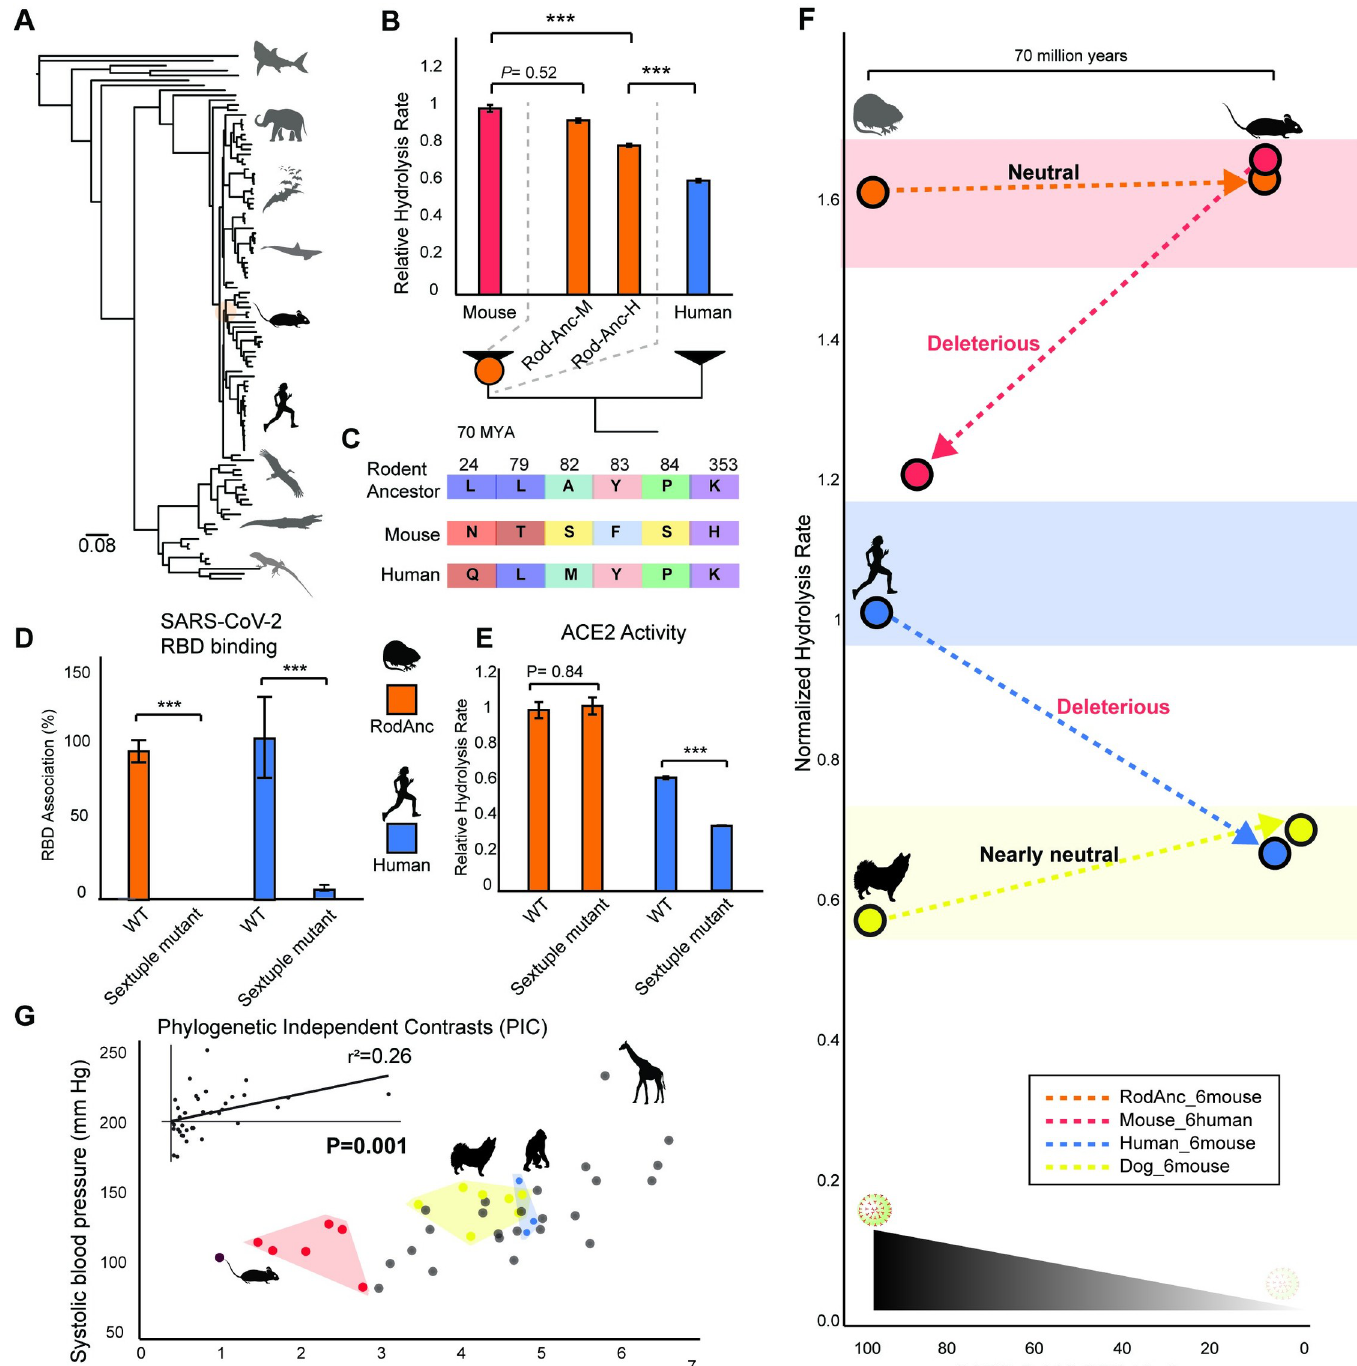
Fig 4. Alternative sequence–function optima in rodent ancestor ACE2 serendipitously confers resistance to SARS-CoV-2 in extant mice. (A) Phylogeny of jawed vertebrates used in the ancestral reconstruction of ACE2 from the last common ancestor of rodents (RodAnc). (B) Evolution of high ACE2 activity in the rodent ancestor. The carboxyl terminus of mouse (M) or human (H) was used to determine hydrolysis rates of a fluorometric peptide. N = 4 to 5 biological replicates. Standard error is shown. (C) RodAnc ACE2 displays none of the rare sequence variants unique to the RBD binding domain of mice. (D) Flow cytometry analysis of SARS-CoV-2 S RBD binding to RodAnc-M and human ACE2. Sextuple mutants of each contain the 6 mouse variants. N = 3 biological replicates. Standard deviation is shown. (E) Hydrolysis rates of WT and mutant ACE2. N = 5 biological replicates. Standard error is shown. (F) Residues conferring mice with resistance to SARS-CoV-2 are unlikely to evolve in humans due to antagonistic pleiotropy with human ACE2 hydrolysis rates. This antagonistic pleiotropy is absent from dogs and the rodent ancestor. All data points